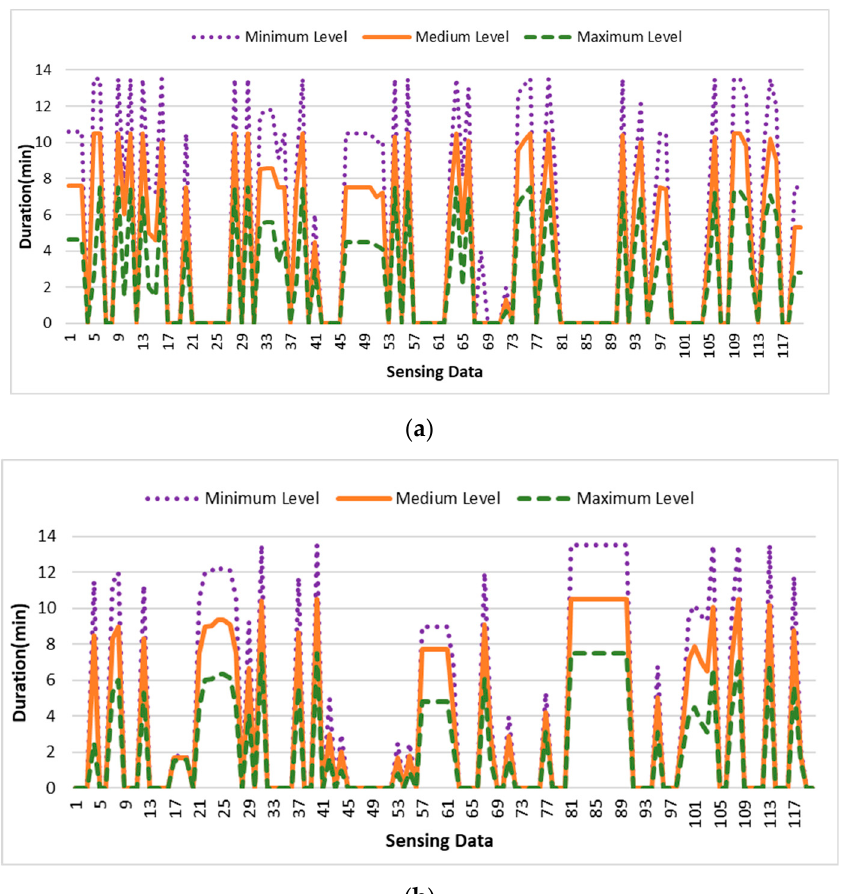
Figure 14. Operational duration results based on different working levels. ( a ) Water pump. ( b ) Overflow system.